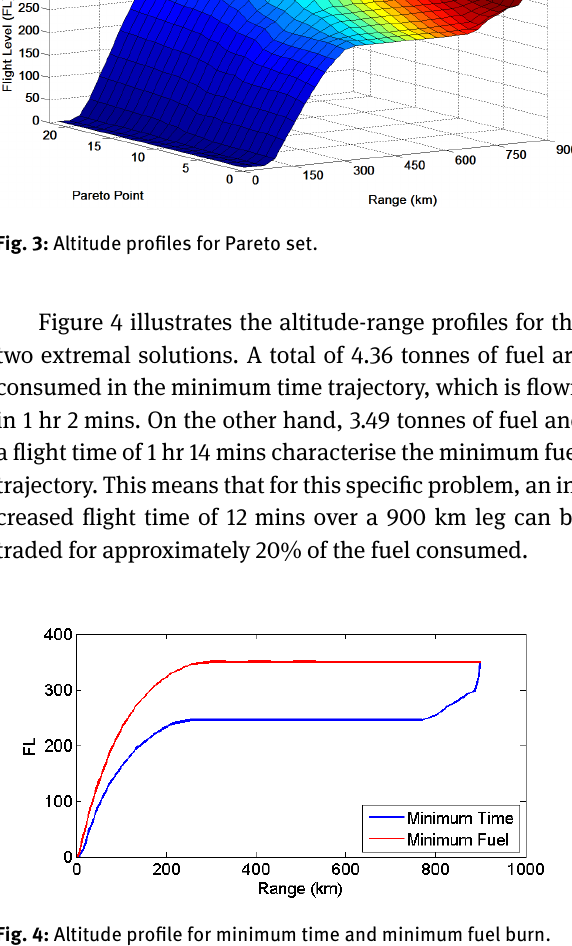
Fig. 4: Altitude profile for minimum time and minimum fuel